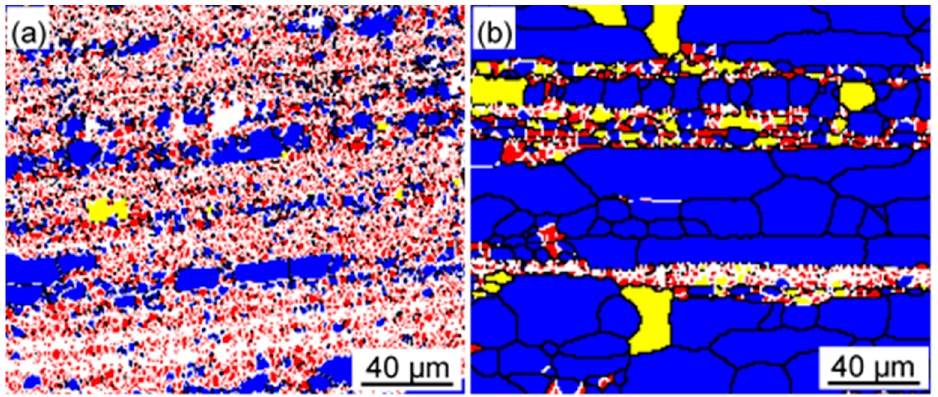
Figure 11. The magnified local structure distribution of 2195 Al-Li alloy sheets before and after solution with the annealing treatment at 400 °C. ( a ) Before solution and ( b ) after solution.